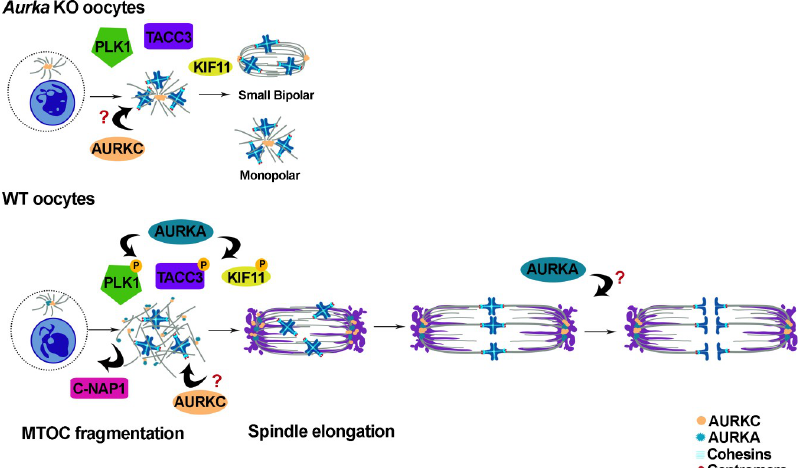
Fig 8. Schematic comparing WT and Aurka KO MI events. In Aurka KO oocytes, AURKC still localizes to aMTOCs but phosphorylated PLK1 is reduced, C-NAP1 persists at aMTOCs and aMTOCs fail to fragment. TACC3 does not localize properly. Some spindles are monopolar, but other spindles can become bipolar, but they are short. The result is an MI arrest. In WT oocytes, AURKA and AURKC localize to aMTOCs, but likely in distinct regions. AURKA is required to phosphorylate PLK1 to induce C-NAP1 release from aMTOCs and initiate aMTOC fragmentation and likely phosphorylates KIF11 and